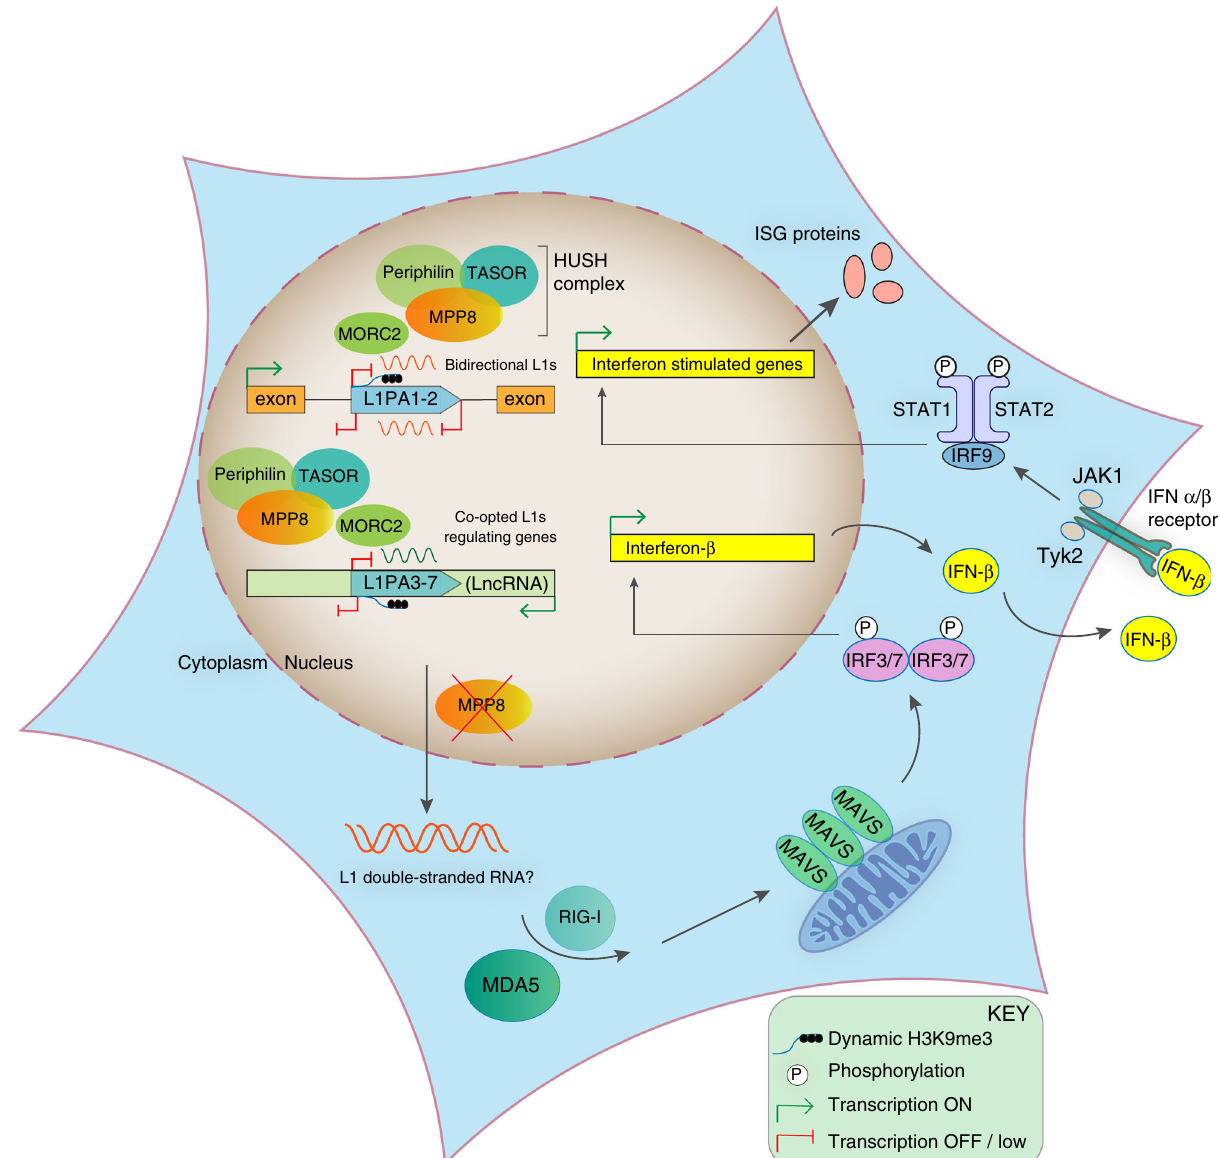
Fig. 7 Proposed model. Inactivation of the HUSH component MPP8 leads to increased expression of bidirectionally-transcribed full-length young LINE-1s (L1PA1 and L1PA2), as well as primate-conserved LINE-1s with potential co-opted roles in gene regulation, (some enriched in long non-coding RNAs). Nucleic acid sensing ensues through dsRNA sensors MDA5 and RIG-I, leading to MAVS signaling and activation and secretion of type I IFNs. IFN- α / β then act on the same cells or bystander cells to mediate induction of IFN-stimulated genes through JAK-STAT signaling. MPP8-depletion is also accompanied by DNA damage and is a factor commonly downregulated in cancers, where its decreased mRNA expression is associated with a dominant IFN immune subtype